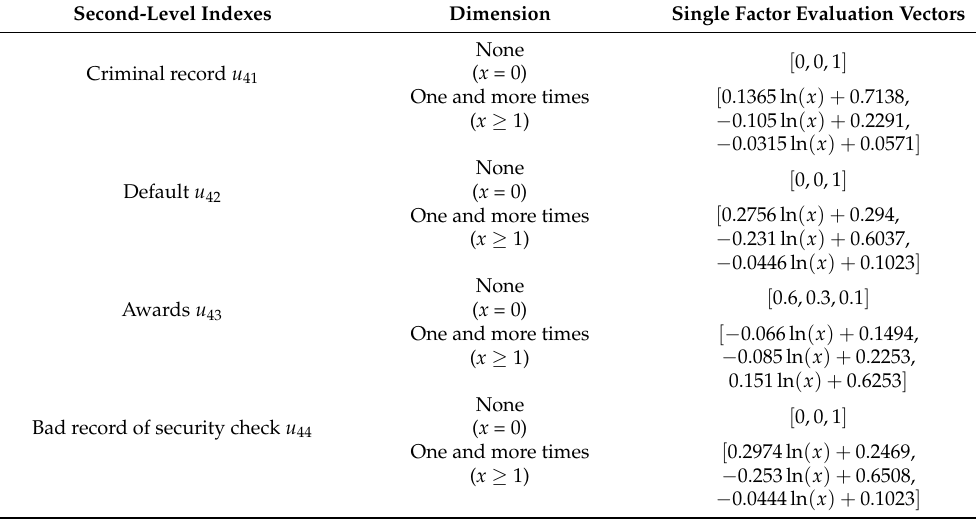
Table 12. Single factor evaluation of personal conduct indexes.